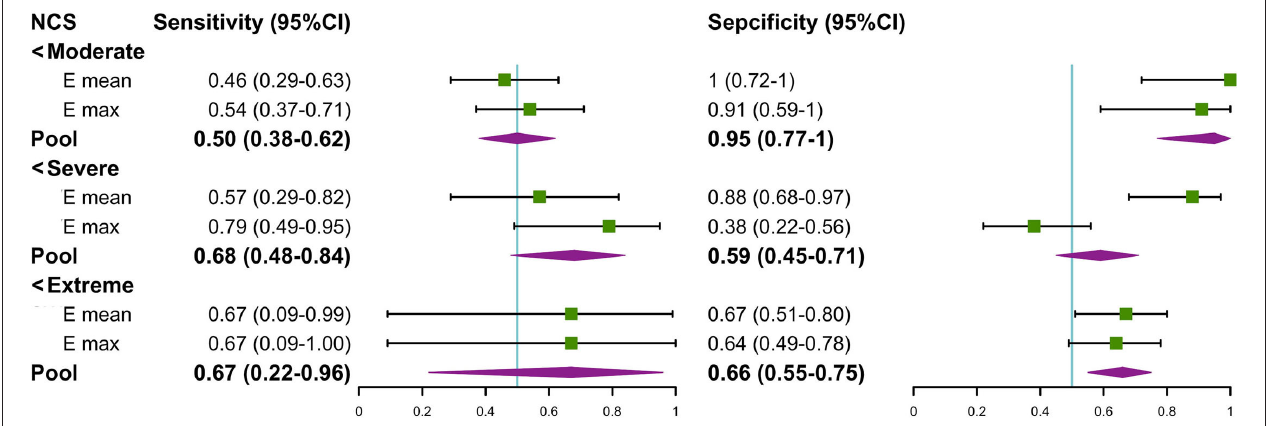
FIGURE 5 | The forest plot about the pool sensitivity and pool specificity of the three groups. NCS, nerve conduction study; TCL, transverse carpal ligament; SWE, shear wave elastography.